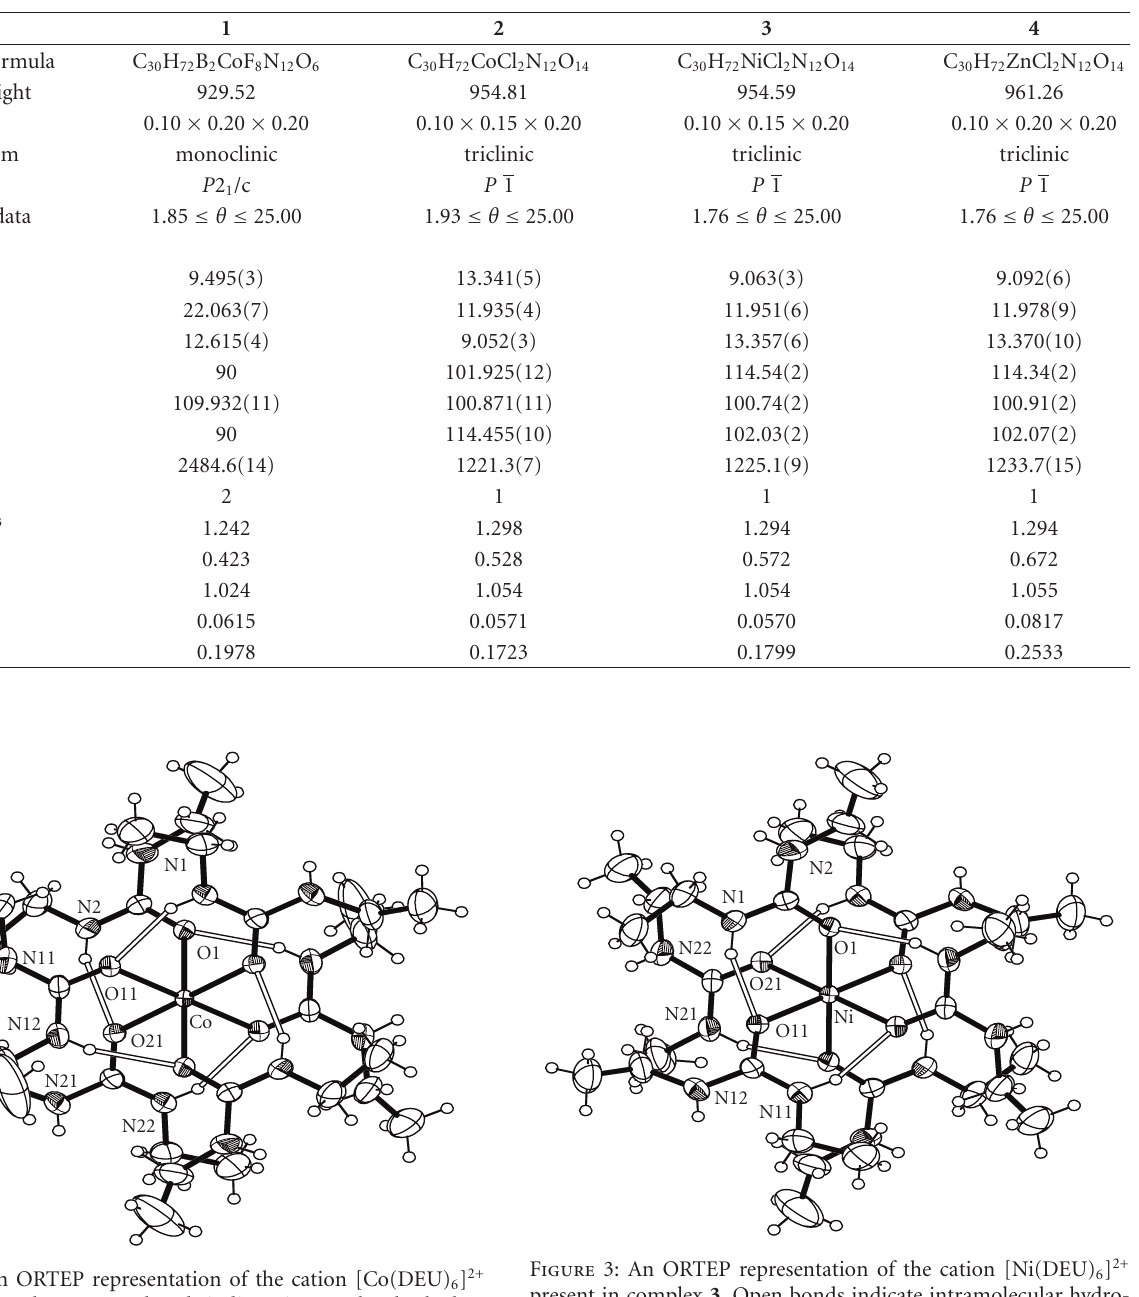
Table 1: Crystal data and structure refinement for 1 – 4 .